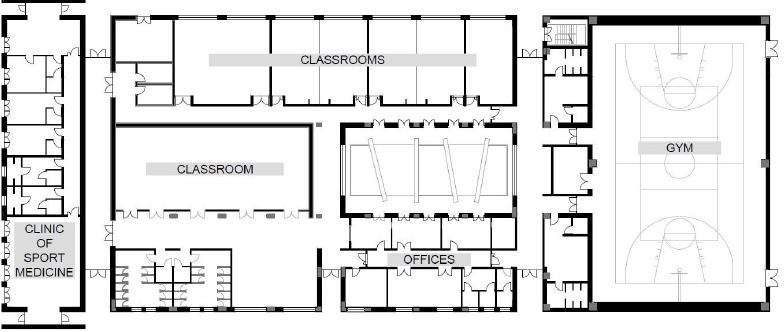
Figure 1. The test